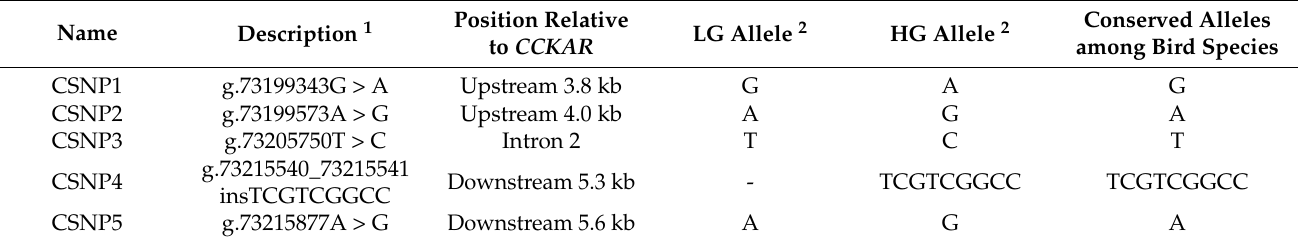
Table 2. Information of five conserved sequence variants.